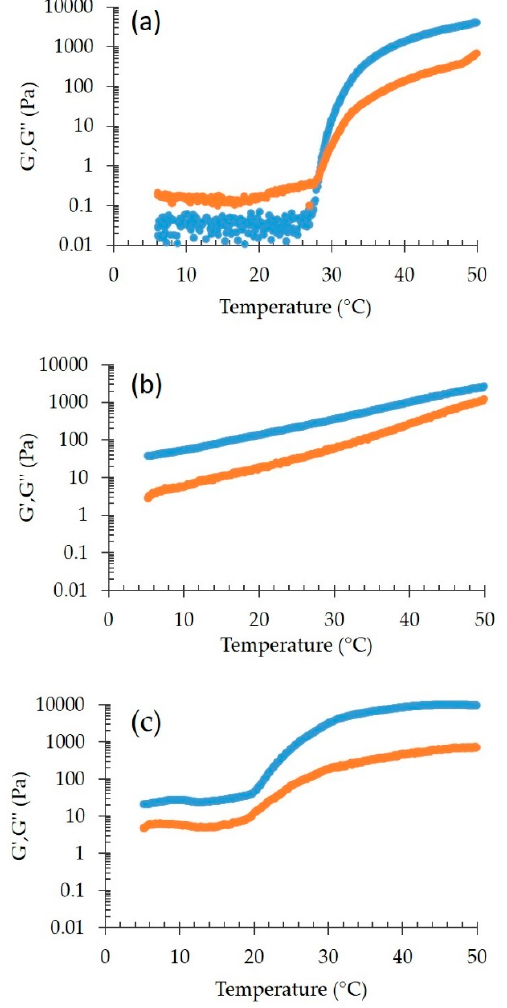
Figure 8. Temperature effect on elastic (G', blue) and viscous (G'', orange) moduli for P-P188-CA ( a ), SLN-CA ( b ), and SLN-P-CA ( c ).